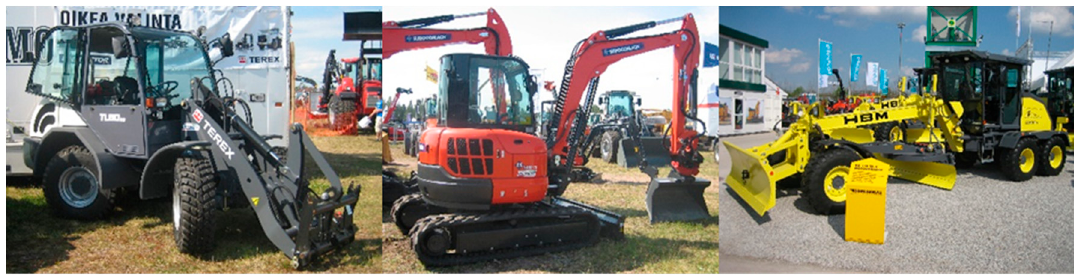
Figure 2. Terex wheel loader, Eurotech mini excavator, and HBM grader (Photos: Antti Lajunen).